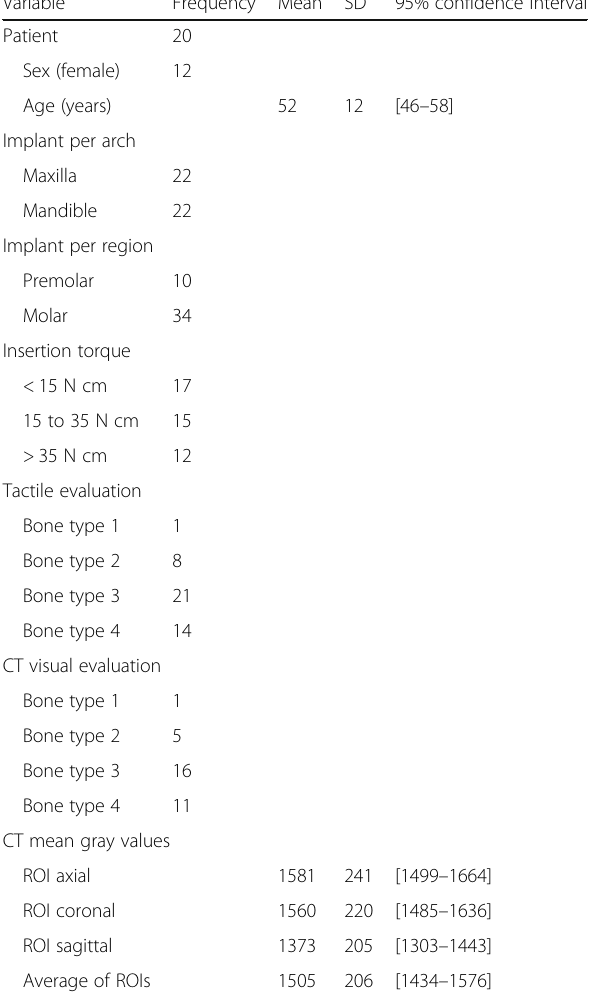
Table 1 Descriptive statistics of the